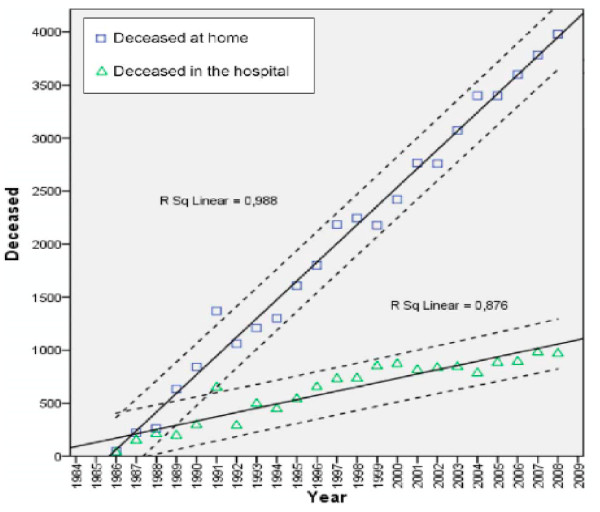
Number of patients deceased at home (blue square), and in the hospital (green triangle) from 1986 to 2008 and the related linear regression lines. Every year, more ANT patients died at home than died in hospice or hospital; this proportion increased from 60% in 1987 to 80% in 2007.